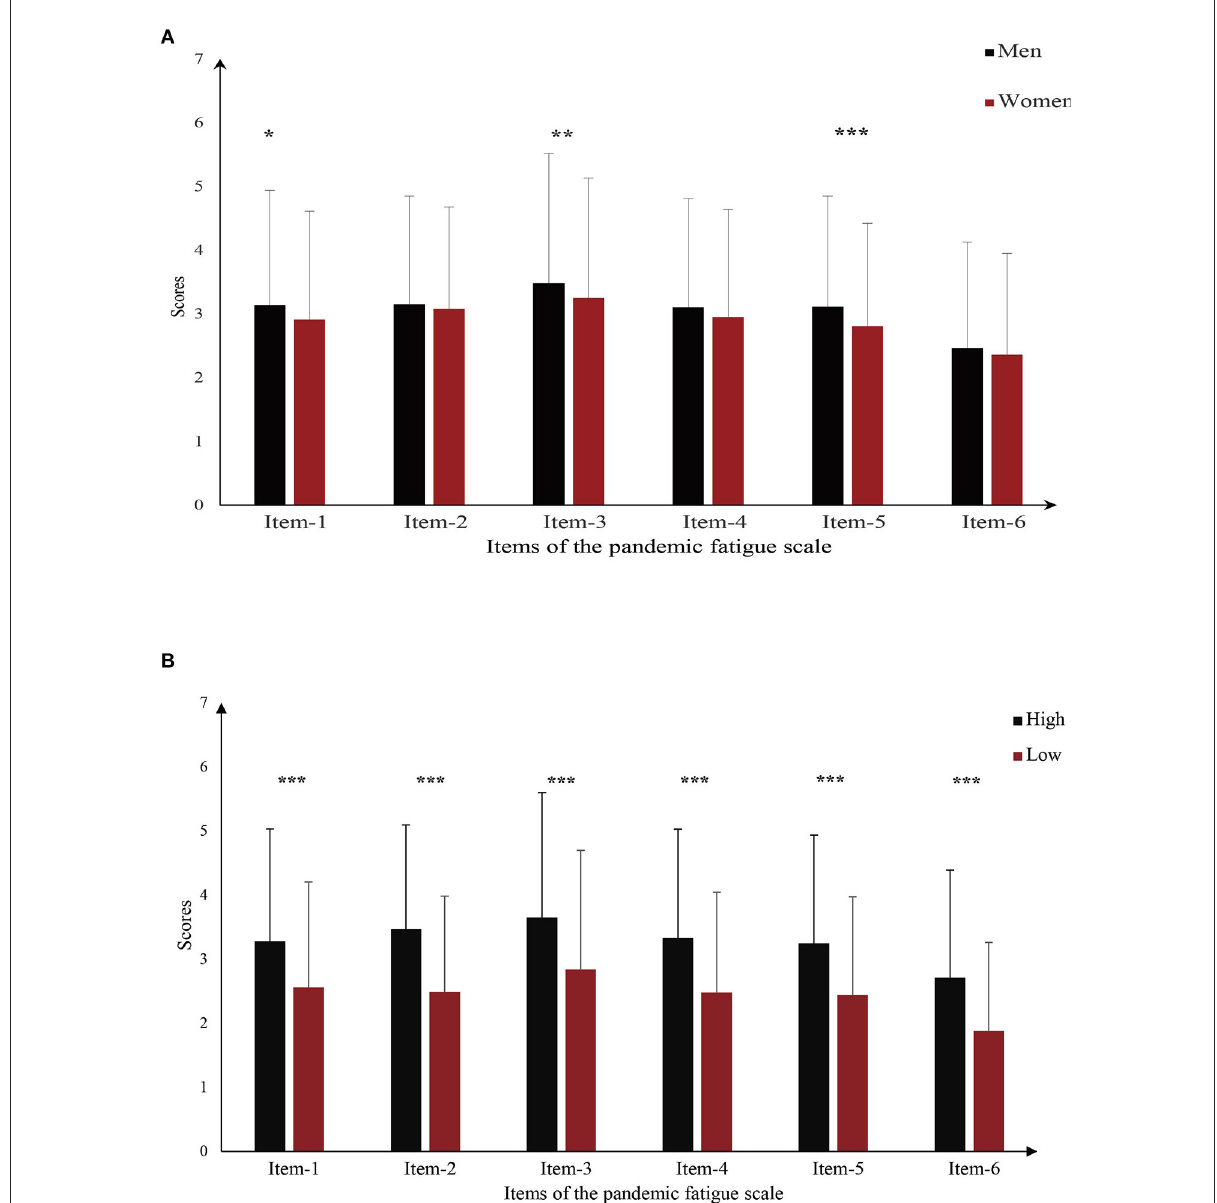
scores of each item were significantly higher for respondents COVID-19